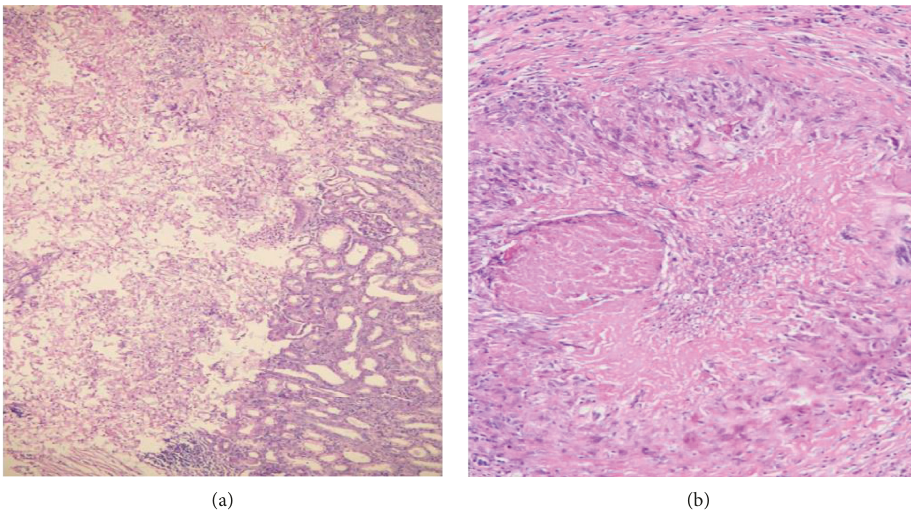
Figure 3: (a) Renal parenchyma with abrupt necrosis and presence of broad-based, aseptate fungal hyphae showing 90 ° branching (HE × 100). (b) Invasion of the blood vessel by similar fungal profiles (PAS ×